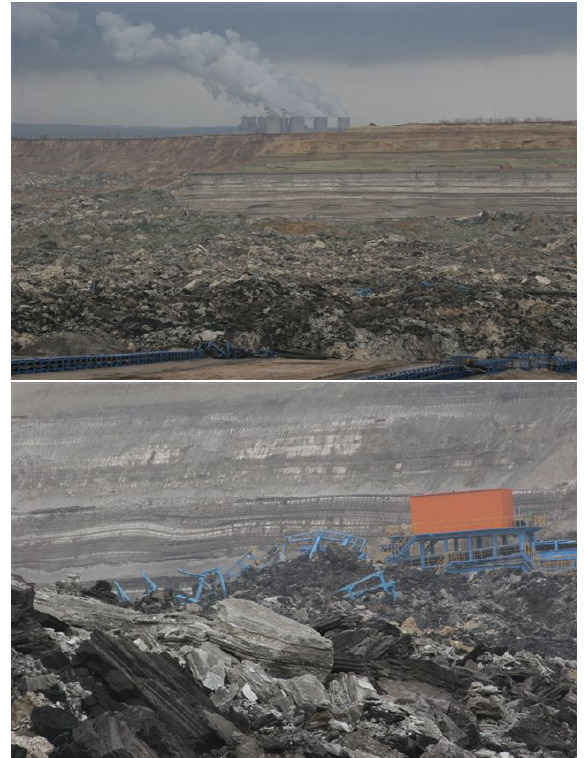
Figure 1: Overview of a real-world accident where a complete daylight coal mining site has collapsed. Several people have been killed and many objects have been buried.